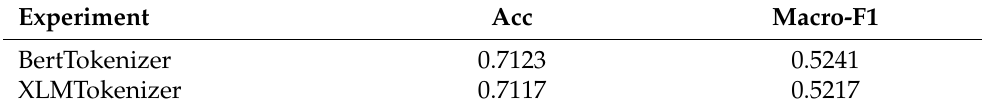
Table 19. Results obtained with subword tokenization for economic activity prediction, using